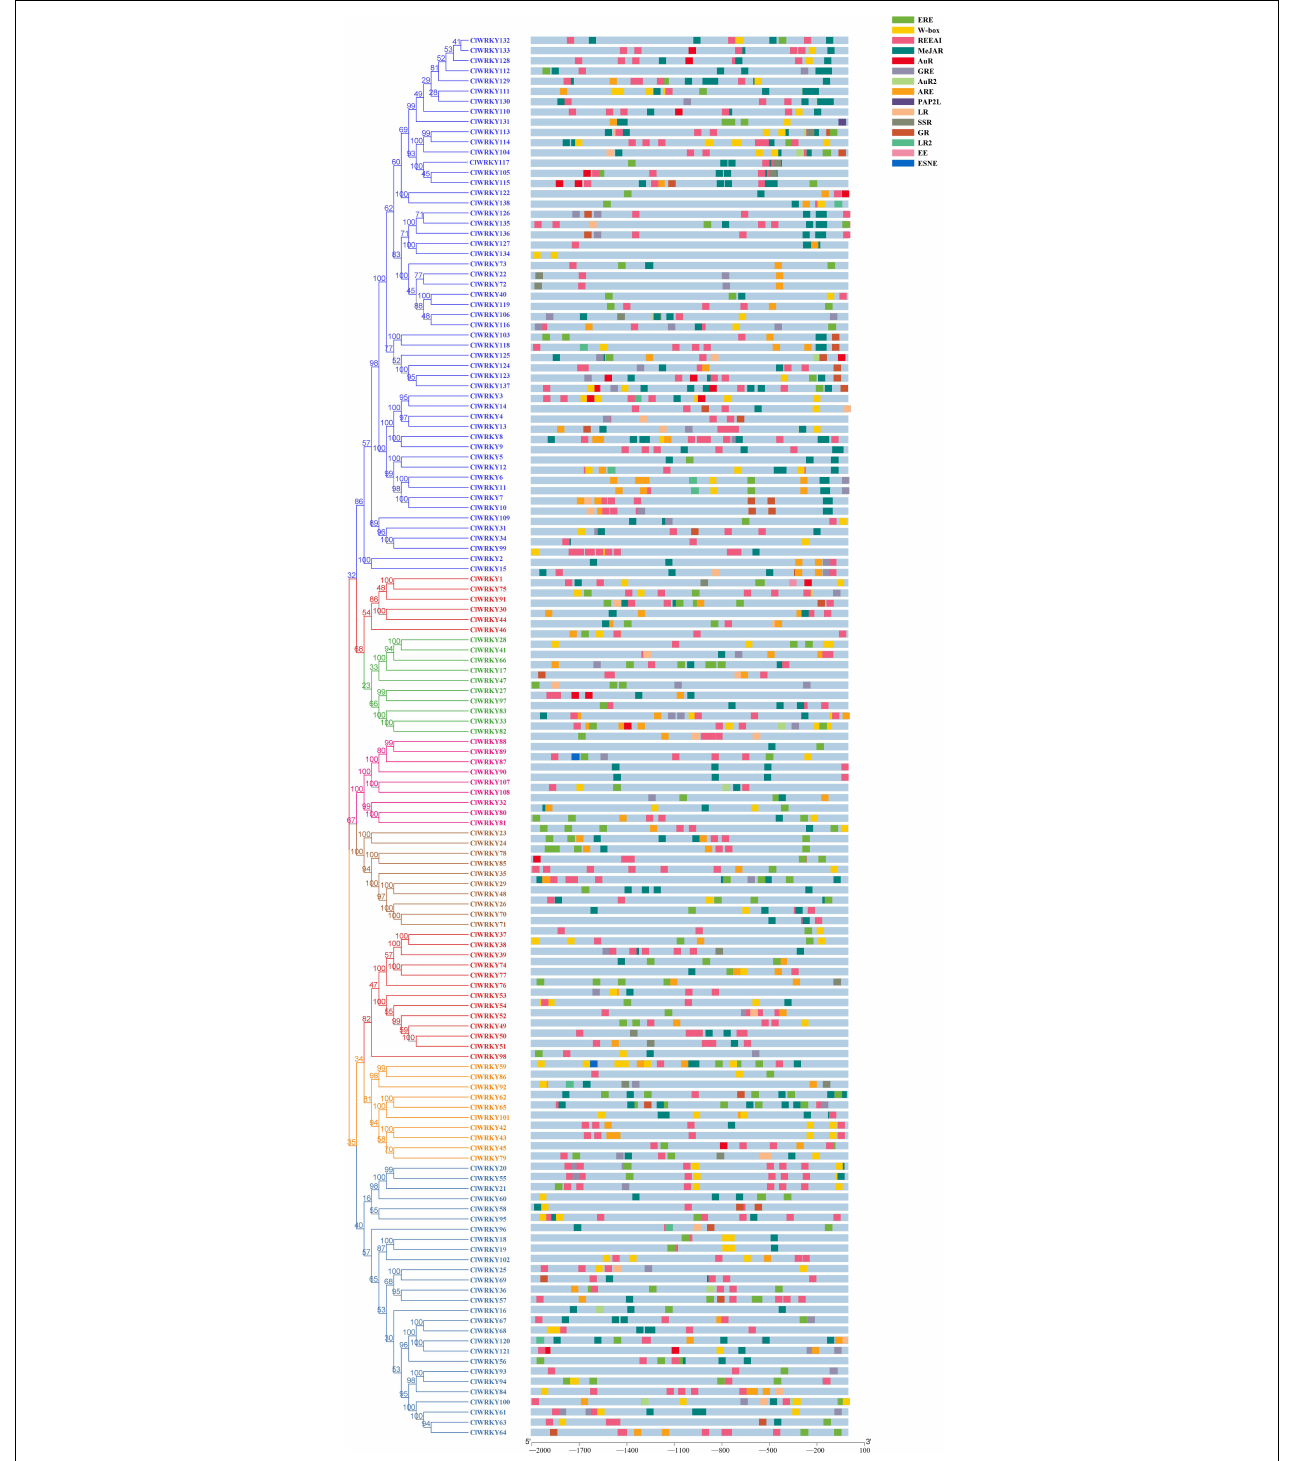
FIGURE 6 | Cis -acting element analysis in the promoter region of the ClWRKY family. The PlantCARE software was used to search the cis -acting elements. Abbreviation of important cis -acting elements are as follows: EE, endosperm expression; ARE, auxin-responsive elements; GR, gibberellin responsiveness; LR, light responsiveness; REEAI, regulatory element essential for anaerobic induction; AuR, elements involved in auxin responsiveness; SSR, seed-specific regulation; MeJAR, methyl jasmonate responsiveness; ERE, ethylene-responsive elements; GRE, gibberellin responsive elements; ESNE, endosperm specific negative expression; LR2, elements involved in light response; PAP2L, plant-AP2 such as AuR2, part of auxin responsiveness; and W-box, recognition site of WRKY TFs.